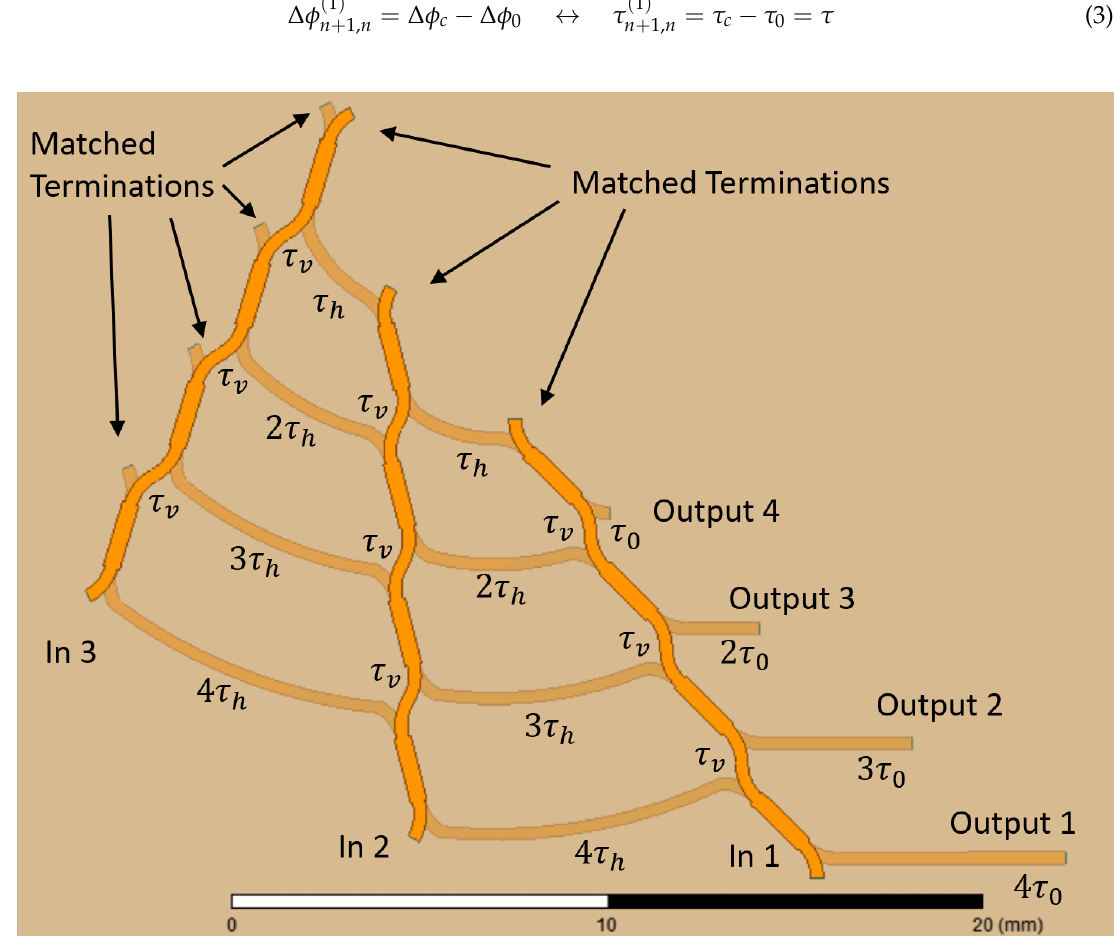
Figure 8. Layout of the proposed circular mm-Wave Blass matrix